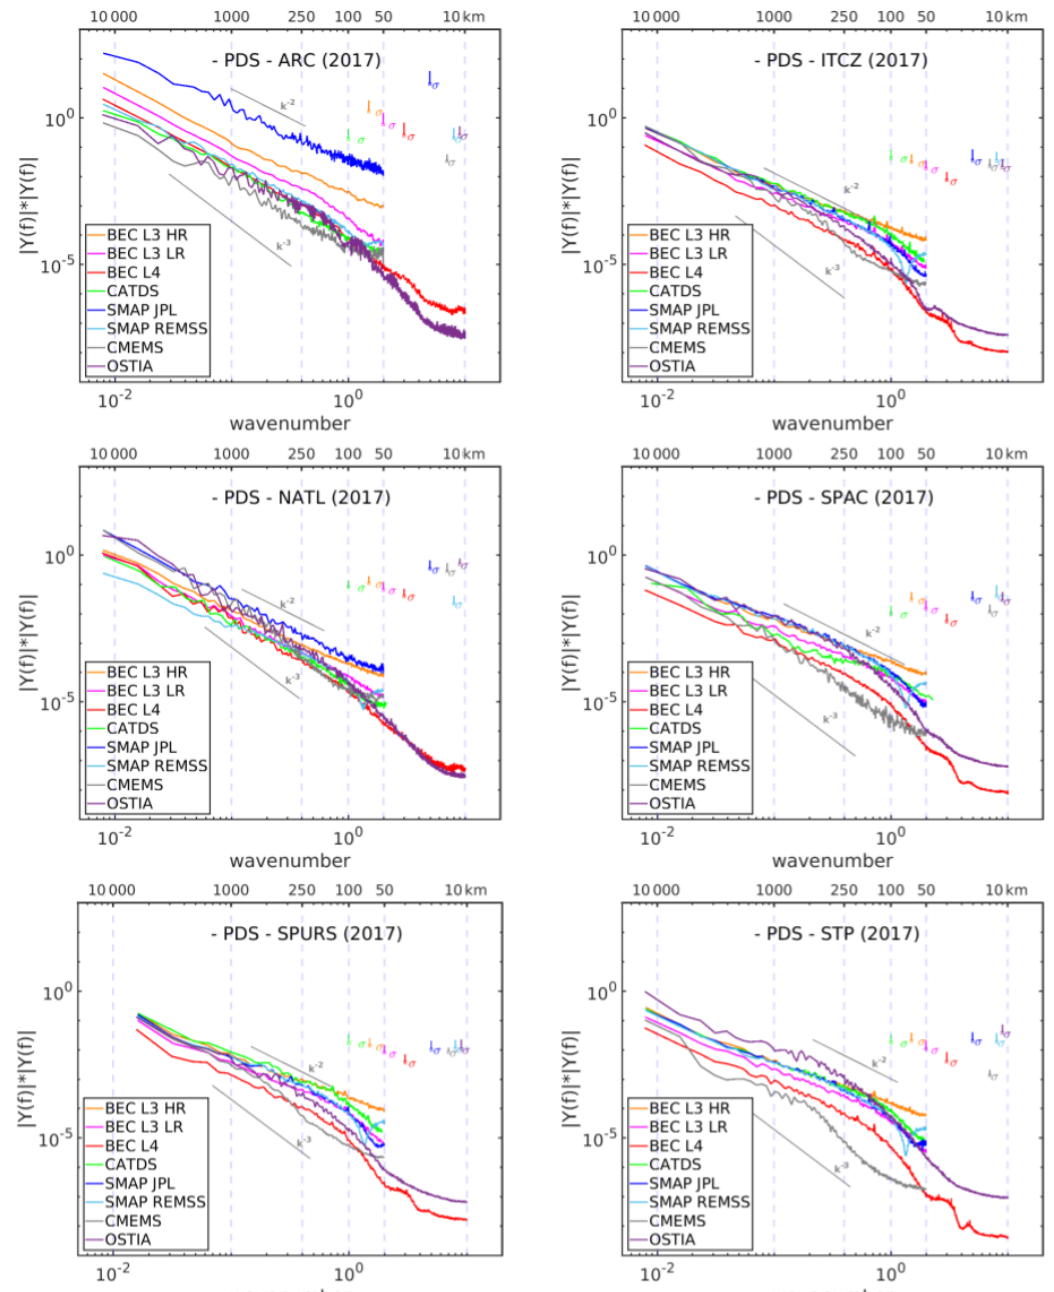
Figure 14. Power density spectra of the different SSS